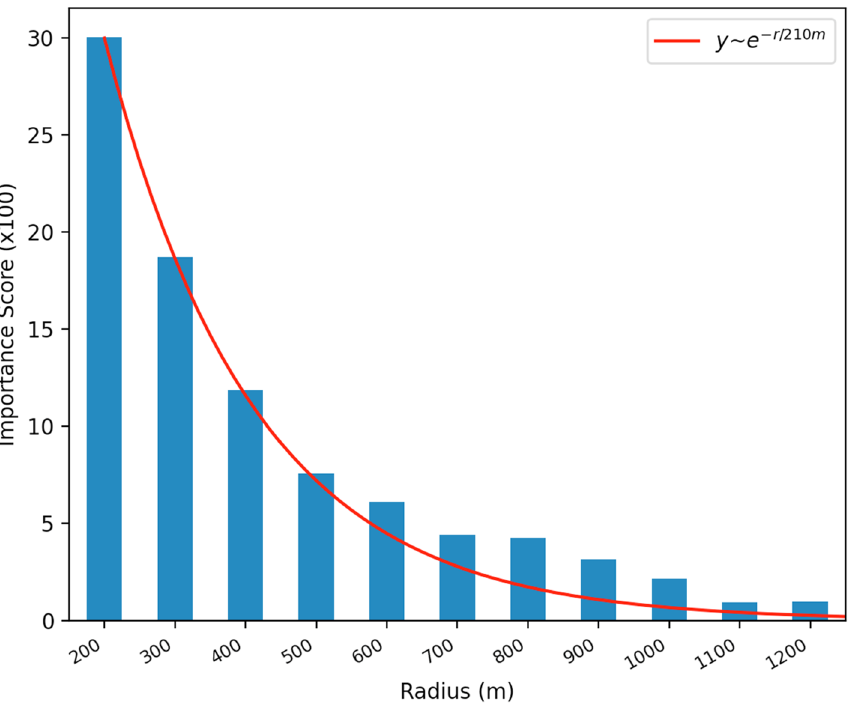
Figure 3. Exponential decay of panel density importance with larger radii. Feature importances (presented multiplied by 100) are derived from 10 different models, each with the same set of socio-economic and demographic variables. In each model, a different radius is chosen over which density is calculated where just the increase in area compared to the next smaller radius is considered. The height of the bar indicates the improvement in model performance due to the inclusion of that density feature. The data follow an exponential curve with a decay radius of 210